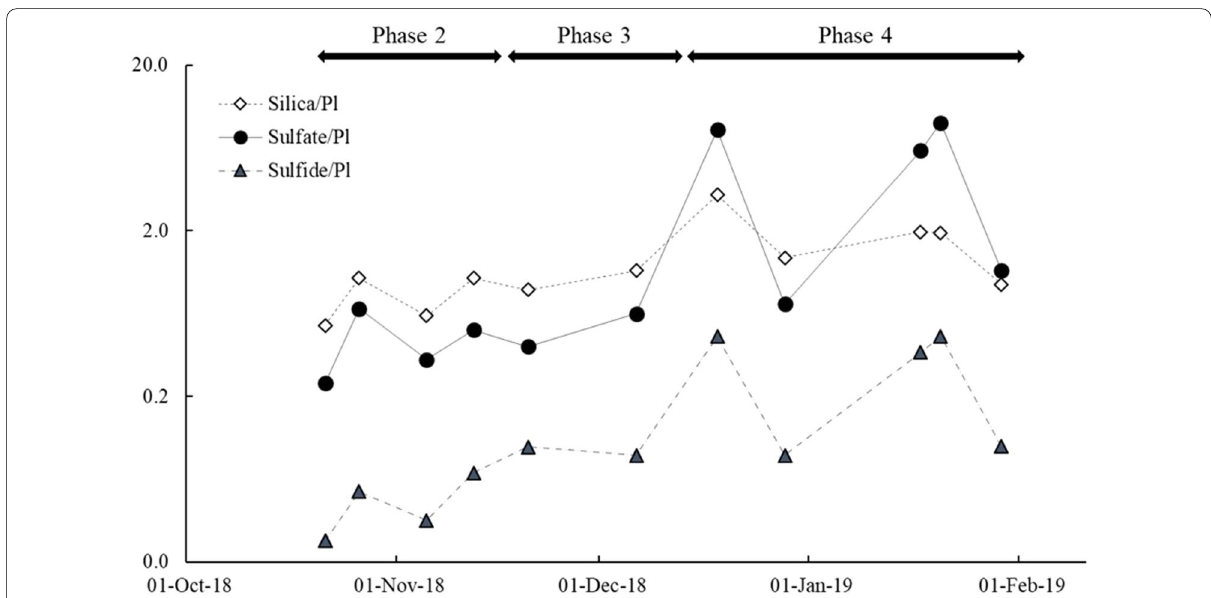
Fig. 4 Temporal variation of X-ray peak intensities of alteration minerals versus rock-forming minerals. The ratios refer to the total peak intensity of maximum peaks of silica minerals of tridymite, cristobalite, and quartz (silica/Pl); sulfate minerals of gypsum, anhydrite, and alunite (sulfate/Pl); and sulfide mineral of pyrite (sulfide/Pl), divided by the maximum peak intensity of plagioclase (Pl),